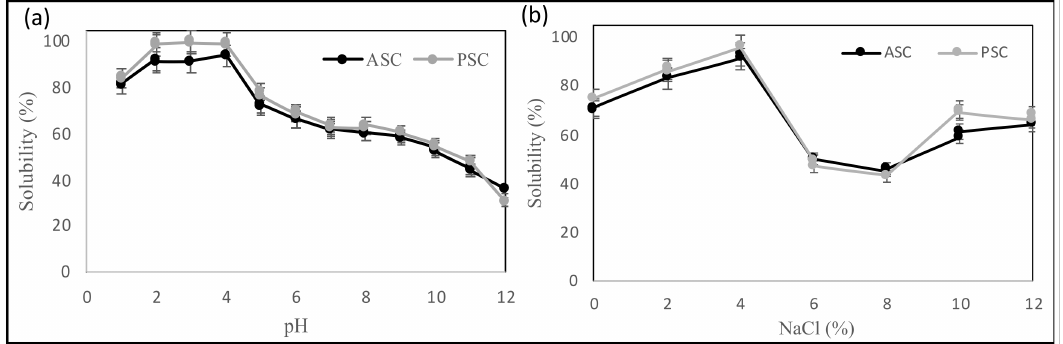
Figure 2. Relative solubility (%) of acid (ASC)- and pepsin (PSC)-solubilized catfish skin collagen as affected by different ( a ) pH and ( b ) NaCl